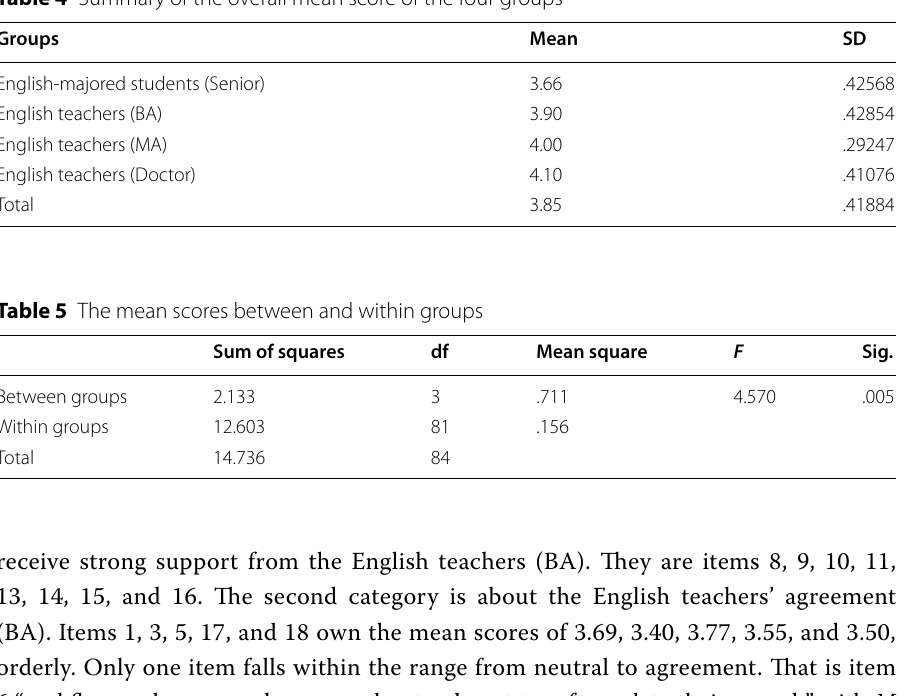
Table 4 Summary of the overall mean score of the four groups Groups Mean